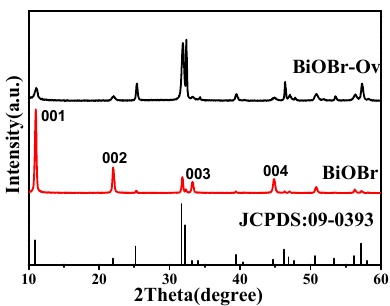
Figure 1. The XRD patterns of the obtained BiOBr and BiOBr-Ov.